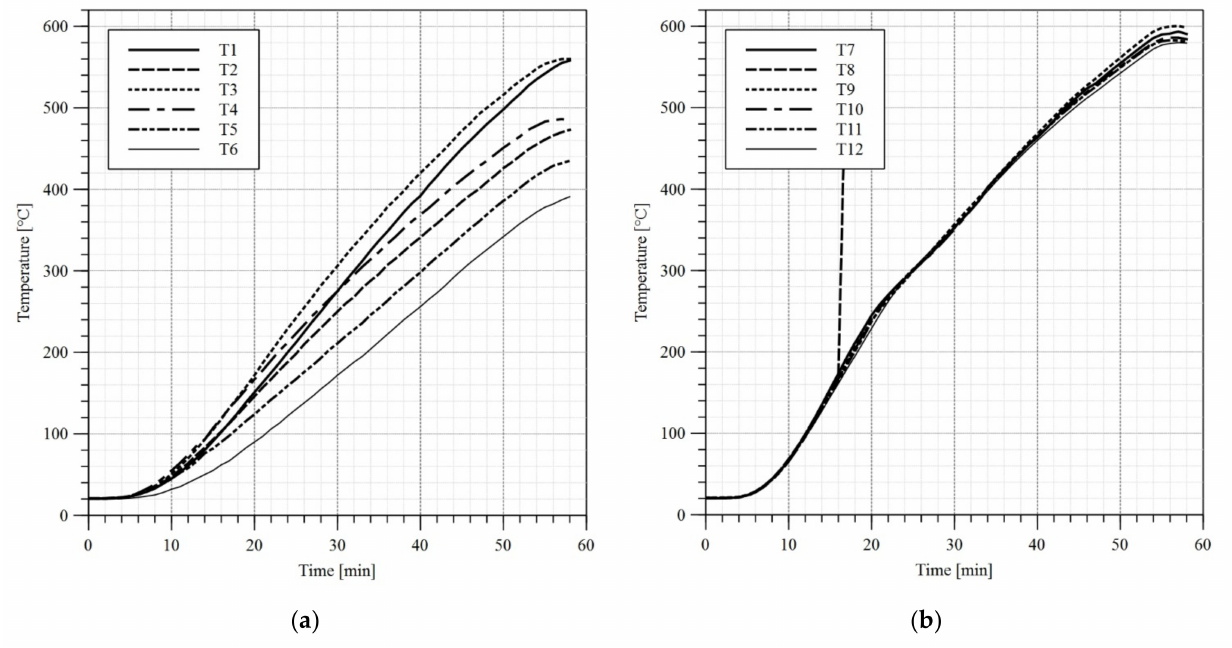
Figure 10. Temperature–time diagram, test B1: ( a ) top and bottom flange; ( b ) web. Sensor no. 8 has been damaged during the